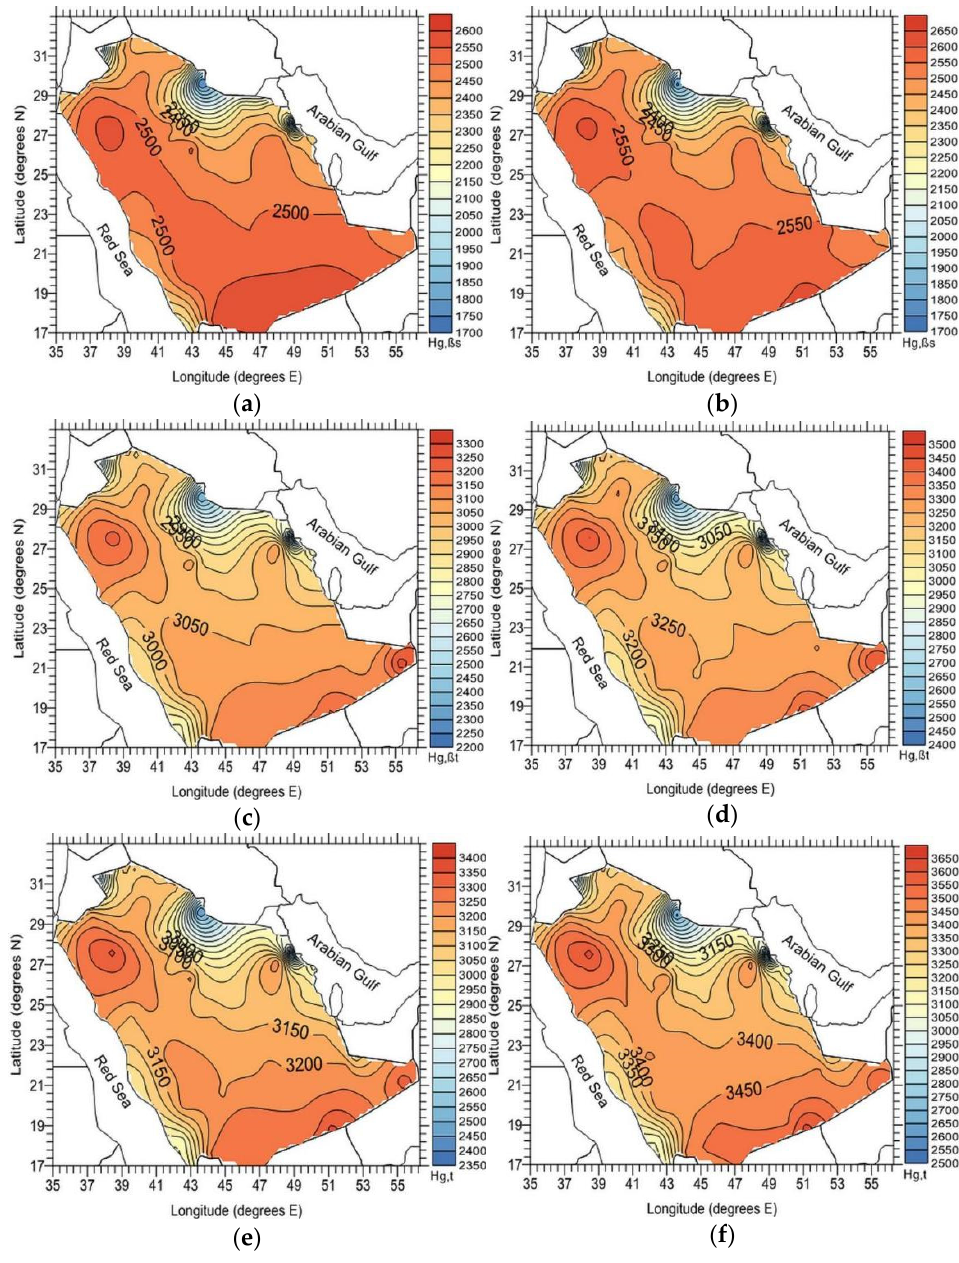
Figure 10. Distribution of the annual solar irradiation sums, H g , averaged over Saudi Arabia in the period 2005–2016 under all-sky conditions. The left maps ( a , c , e ) were derived by using the ISO model, and the right maps ( b , d , f ) with the HAY one. The solar energy potential is shown in the system configuration: mode (i) in ( a , b ), mode (ii) in ( c , d ), and mode (iii) in ( e , f ). Figure 10a is a reproduction of Figure 7b in [30], Figure 10c is a corrected version of Figure 8b in [31], and Figure (in kWhm − 2 year − 1 ).